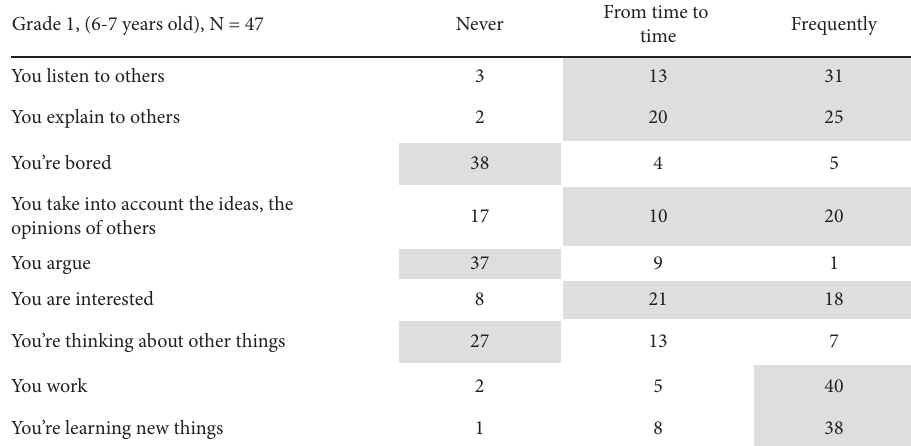
Figure 6: Breakdown of opinions among pupils in grade 1 based on how they work in a group (significance level of p � 0 .